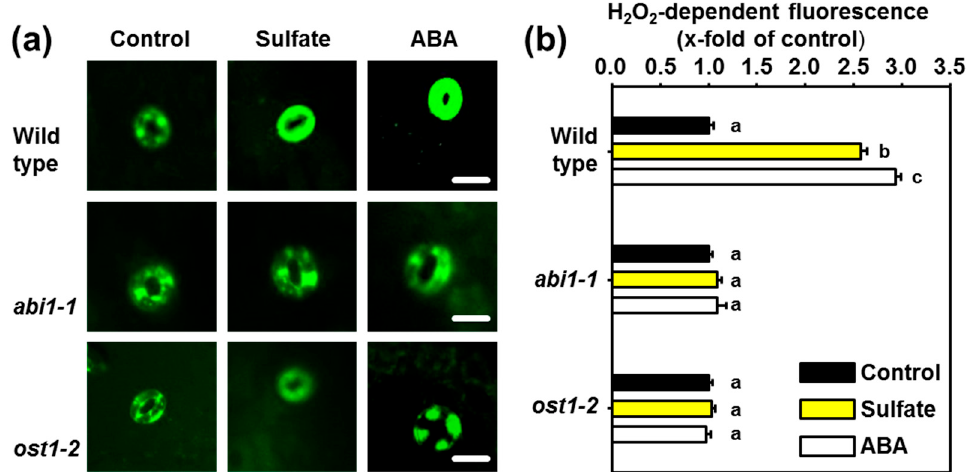
Figure 3. Functional ABI1 and OST1 are vital for the sulfate-induced accumulation of reactive oxygen species in guard cells. ( a ) Visualization of reactive oxygen species (ROS) with the H 2 O 2 -selective dye 2',7'-dichlorofluorescein (H2DCF) as described in material and methods. Epidermal peels of 5-weeks–old soil-grown wild-type, abi1-1 , and ost1-2 plants were floated on water at pH 5.5 or water supplemented with sulfate (15 mM MgSO 4 ) or ABA (50 µ M) for three hours prior staining of ROS. ( b ) Quantification of ROS staining in guard cells floated on water (control, black) supplemented with sulfate (15 mM, yellow) or ABA (50 µM, white). Letters indicate statistically significant differences between groups determined with the one way ANOVA test ( p < 0.05, n = 50 stomata, derived from epidermal peels of five individual plants). Values represent means ± standard deviation (SD). Scale bar, 10 µm.